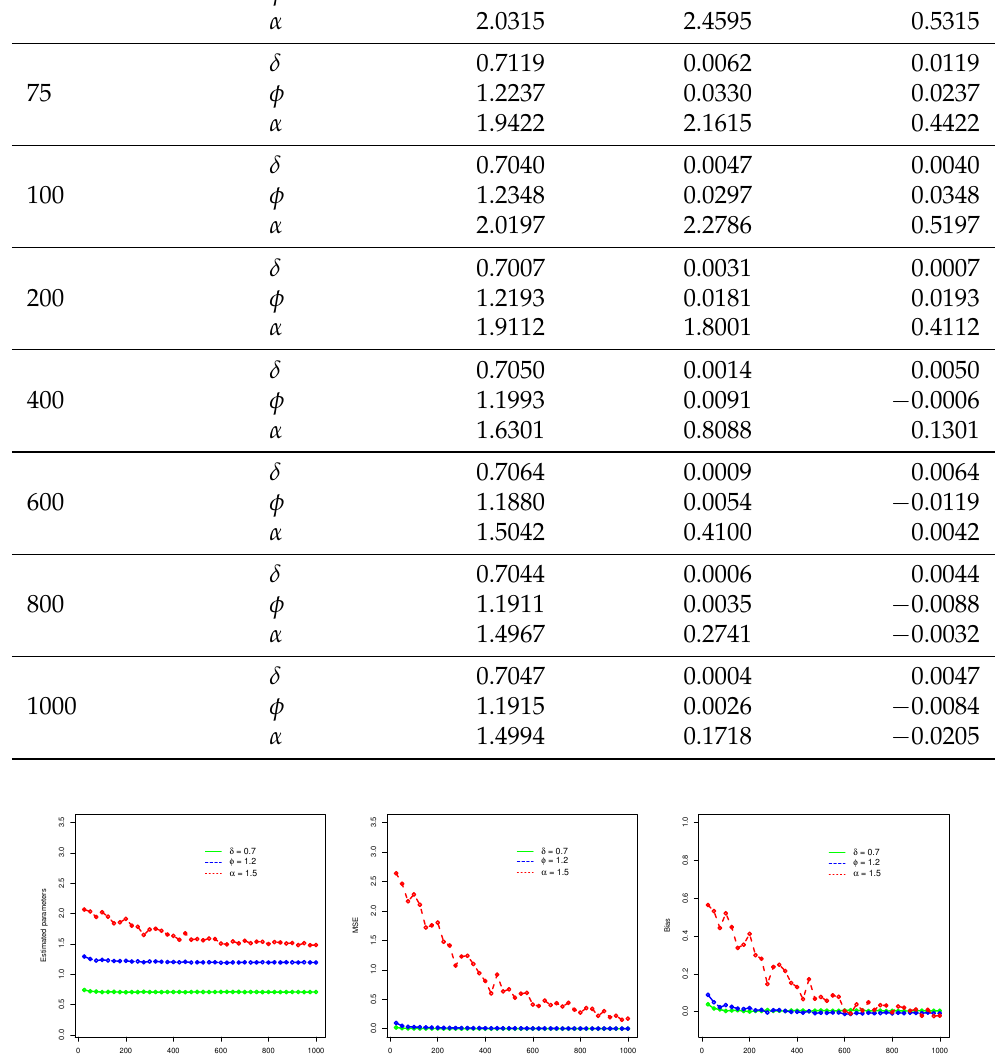
Figure 8. The visual illustration of the SS of the NACos-Weibull distribution for δ = 0.7, φ = 1.2, and α =